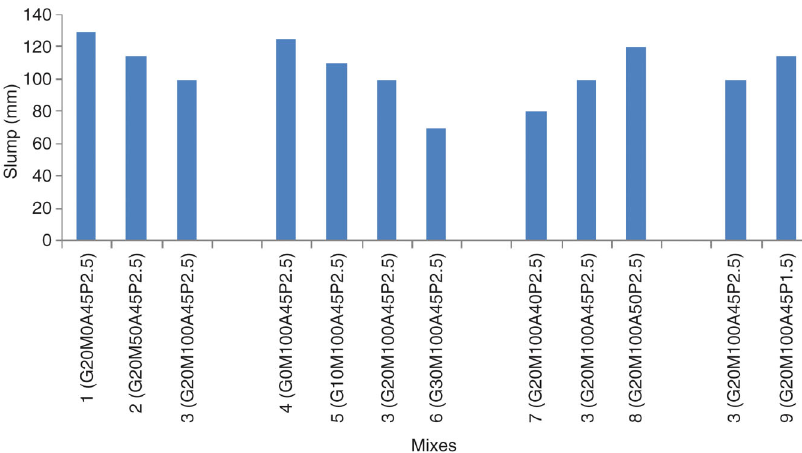
Figure 3: Comparison of slump for geopolymer